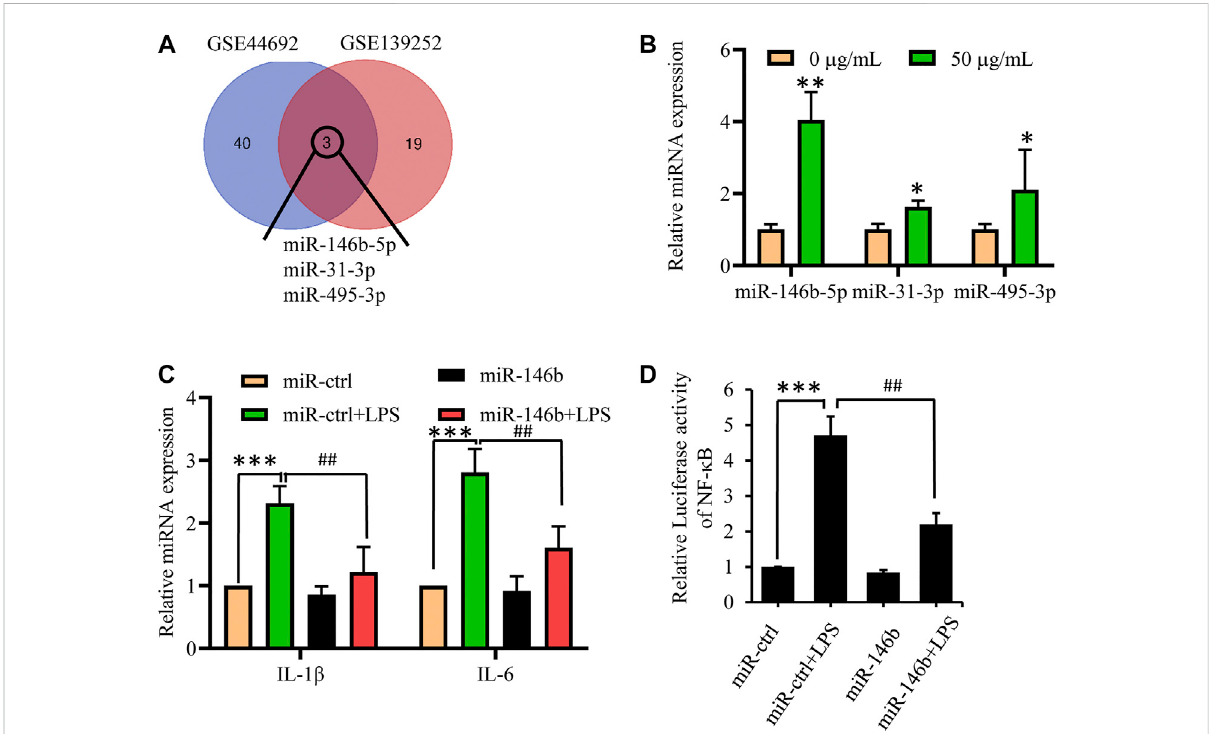
FIGURE 5 MiR-146b-5p is a potential target of GBE to suppress in fl ammation response. (A) Gene expression omnibus (GEO) database (GSE44692, GSE139252) was screened for differentially expressed miRNAs for both GBE and Alzheimer ’ s disease. (B) U87 cells were treated with GBE (0 and 50 µg/ml) for 24 h, and the expression of miR-146b-5p, miR-31-3p, and miR-495-3p were detected by qPCR (* p < 0.05, ** p < 0.01 vs. negative control group). (C) U87 cells were transfected with miR-146b-5p mimics for 24 h, and then incubated with or without LPS (0.1 µg/ml) for 24 h. The expressions of IL-6 and IL-1 β were measured by qPCR. (D) 293T cells were cotransfected with pNF κ B-luc, renilla luciferase reporter, and miR- 146b-5p mimic for 24 h; thereafter, cells were incubated with or without LPS (0.1 µg/ml) for 24 h. Luciferase activity was determined using a